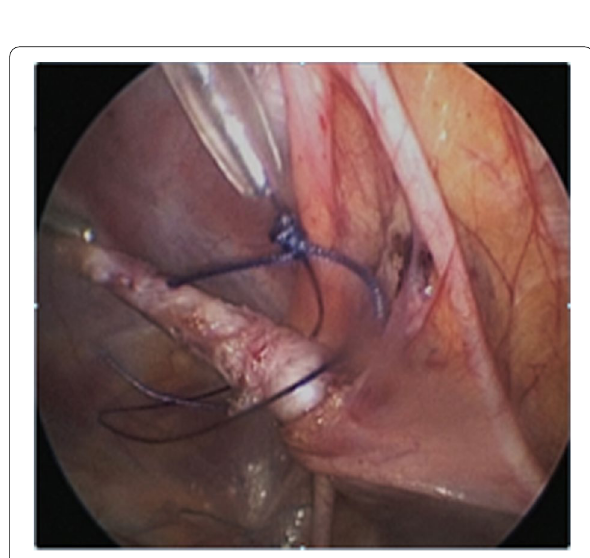
Fig. 2 Laparoscopic view of Roeder loop positioning under urachal